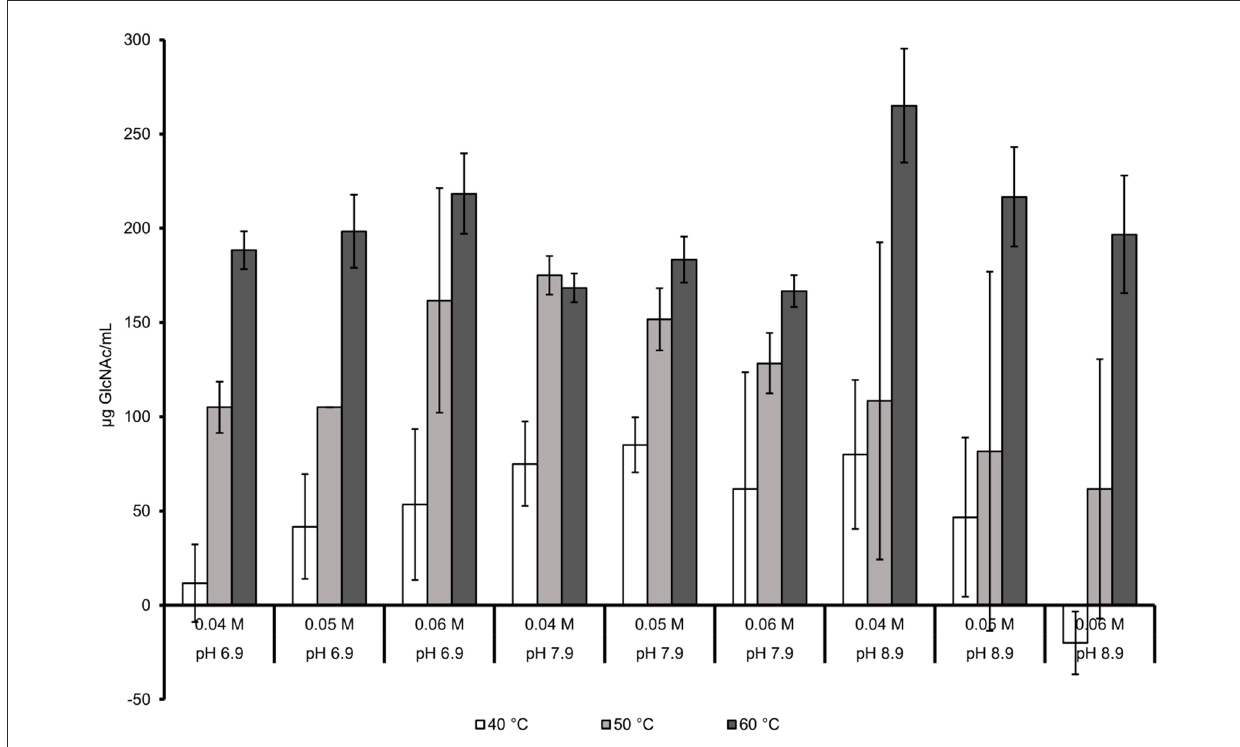
FIGURE2 Joint effect of temperature, pH, and molarity of the buffer with NaCl at 3.554%.